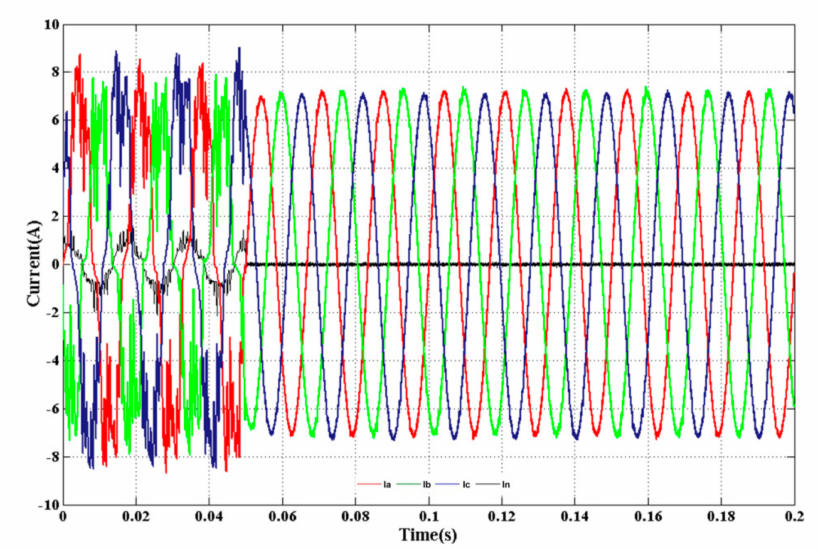
Figure 8. Experimental result of the FNN for case 1.